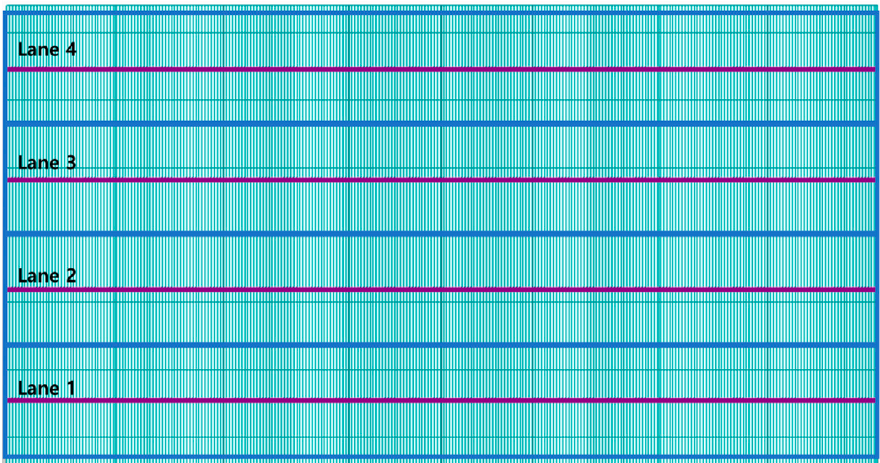
Figure 3. Traffic load points (Lanes 1, 2: right direction, Lanes 3, 4: left direction).